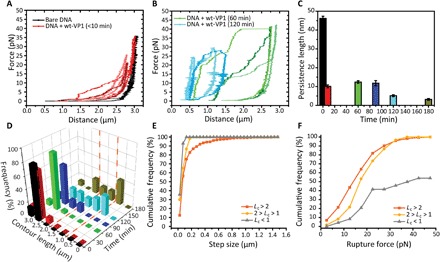
Effect of WT-VP1 pentamer interaction with tethered DNA, followed by AFS in real time.(A) Bare DNA FD curves (black) and DNA in the presence of VP1 FD curves obtained <10 min after addition of WT-VP1 pentamers (red; n = 3). (B) FD curves obtained after incubation for 60 min (green; n = 3) or 120 min (blue; n = 3). (C) Average effective persistence length measured for different incubation times (black, n = 123; red, n = 97; green, n = 25; blue, n = 16; light blue, n = 29; and brown, n = 13; all independent measurements). Error bars represent SEM. (D) Three-dimensional plot displaying the frequency of the Lc as a function of time, same curves as in (C). Bin size is 0.5 μm. (E) Cumulative frequency of the rupture step sizes (337, 60, and 14 rupture events were found in 60, 16, and 13 FD curves with a Lc of >2, between 1 and 2 and <1 μm, respectively). (F) Cumulative frequency of the rupture forces from the same data as in (E).